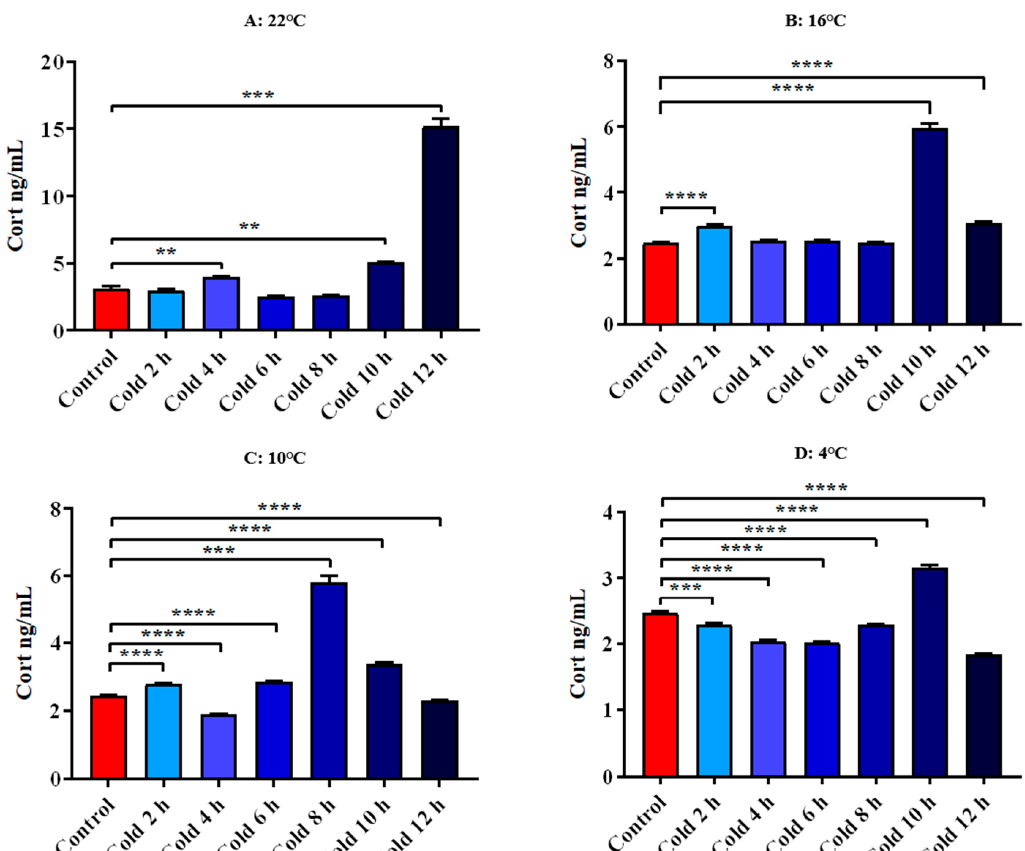
Figure 8. Changes in serum Cort of ICR mice under different intensity of cold exposure. ( A ). Changes in the serum Cort of mice under cold exposure at 22 ◦ C; ( B ). Changes in serum Cort of mice under cold exposure at 16 ◦ C; ( C ). Changes in the serum Cort of mice under cold exposure at 10 ◦ C; ( D ). Change in the serum Cort of mice under cold exposure at 4 ◦ C. Compared with 28 ◦ C normal temperature control group, the difference was significant as ** p < 0.01. *** p < 0.001. **** p < 0.0001. The results showed that CRH levels were significantly decreased at 22 ℃ for 2 h, 4 h, 8 h and 10 h ( p < 0.01). After cold exposure at 16 ℃ for 2 h, 4 h, 6 h 10 h and 12 h, it increased significantly ( p < 0.01). After cold exposure at 10 ℃ for 2 h, 6 h, 8 h and 10 h, it decreased significantly ( p < 0.01). At 4 ℃ cold exposure for 2 h, 4 h, 6 h, 10 h and 12 h, they were significantly decreased ( p < 0.01). All these results are shown in Figure 9.